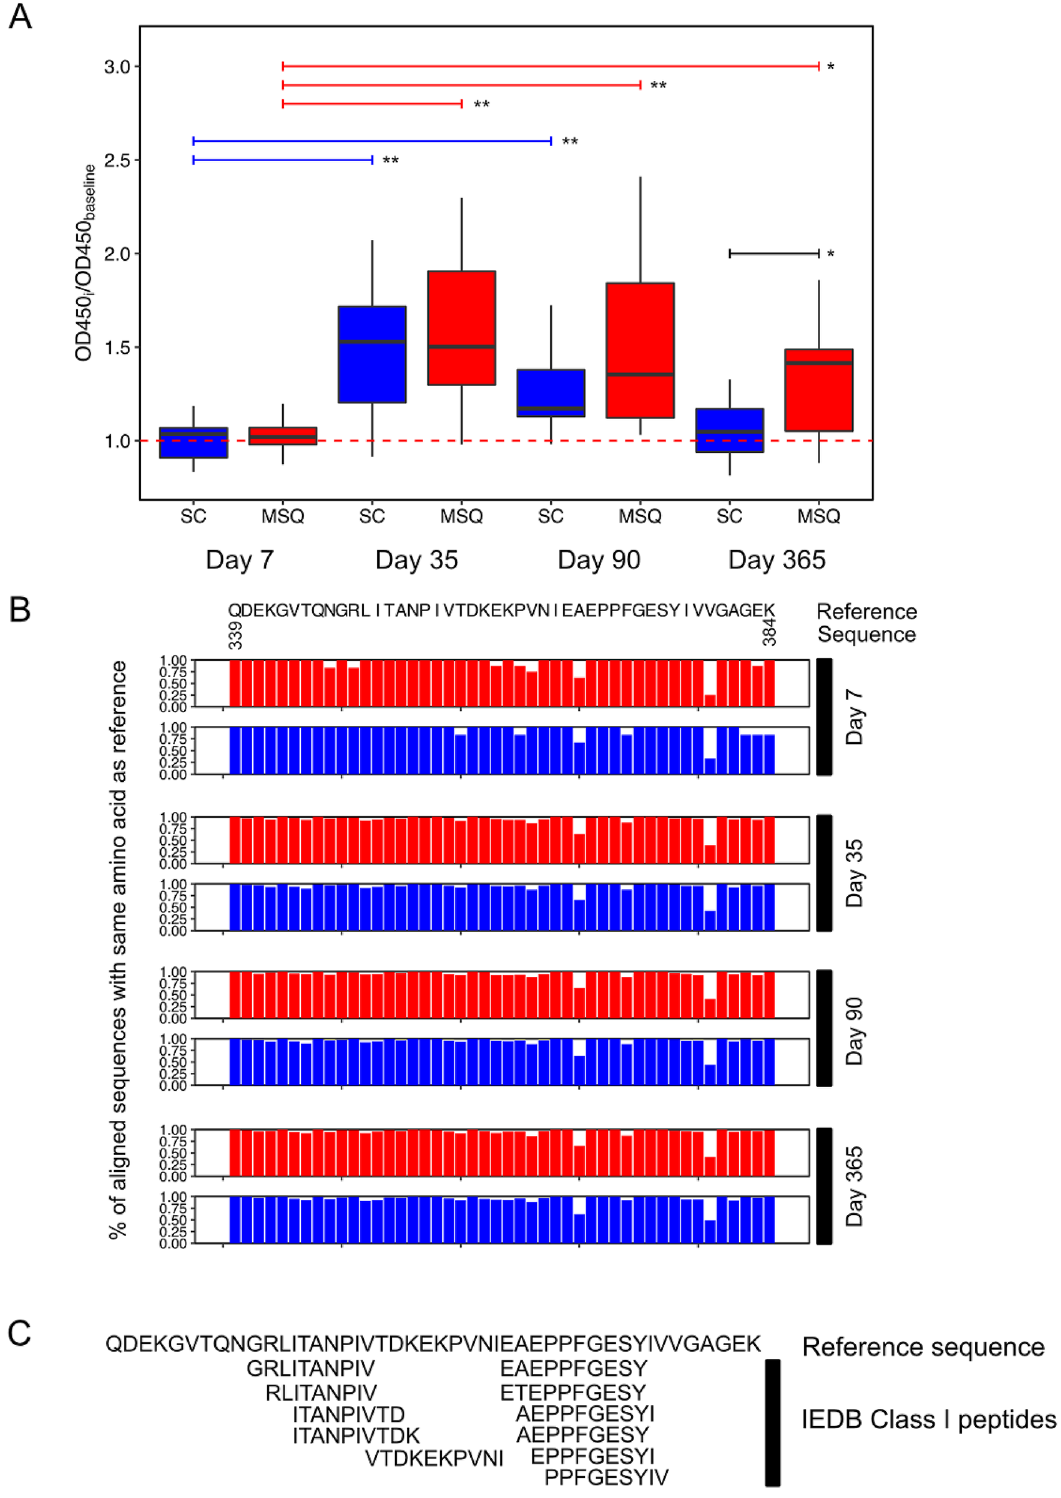
Figure 3. Persistent differences in EDIII sero-reactivity validate by ELISA with PhIP-Seq enriched peptides to this region showing no differences in antibody breadth by the route of inoculation. The region of differential reactivity was cloned into a mammalian expression vector, overexpressed in HEK293T cells and used as the antigen in an ELISA. By ELISA, EDIII seroreactivity in the mosquito-infected (red) but not in the subcutaneously infected (blue) group was significantly elevated at 1 year post-infection as compared to 7 days post-infection ( A ; ** p < 0.01; * p < 0.05). Antibody breadth was similar in both groups, with only 2 positions (E 368 , E 379 ) with < 70% conservation of the reference sequence residue ( B ). Several MHC Class I peptides, but no Class II epitopes from the immune epitope database (IEDB) mapped to the region of interest ( C